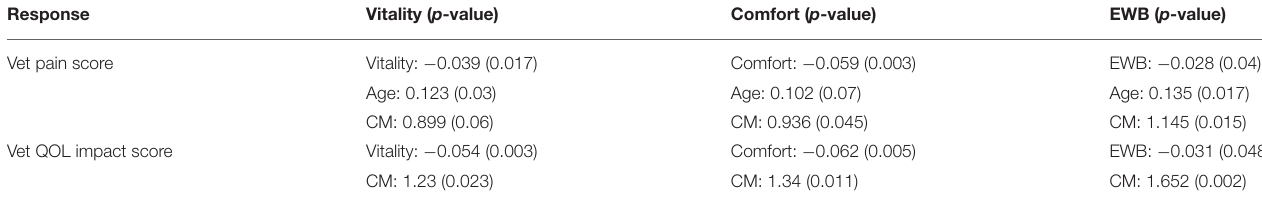
TABLE 4 | Results from regression model fitted with vet-assessed QOL impact and pain scores, and HRQL domains Vitality, Comfort and Emotional wellbeing (EWB), taking into account age (in years) and the number of co-morbidities (CM) present. Response